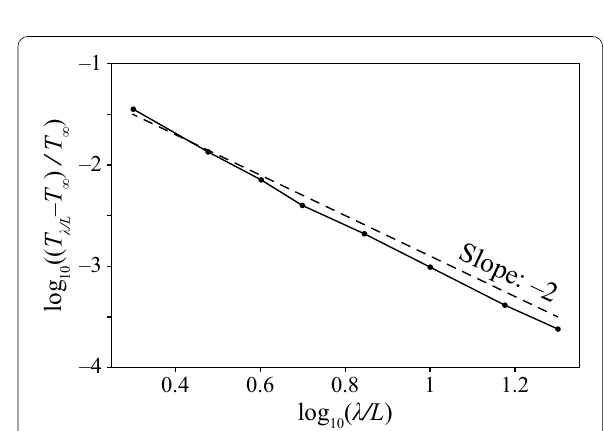
Fig. 4 Artificial extension of the earthquake recurrence interval due to periodic boundaries normalized by the case without periodic boundaries. The intervals between the fourth and fifth earthquakes were used. The black points connected by black lines are simulated points, and the dashed line indicates dependency of ( λ / L ) −